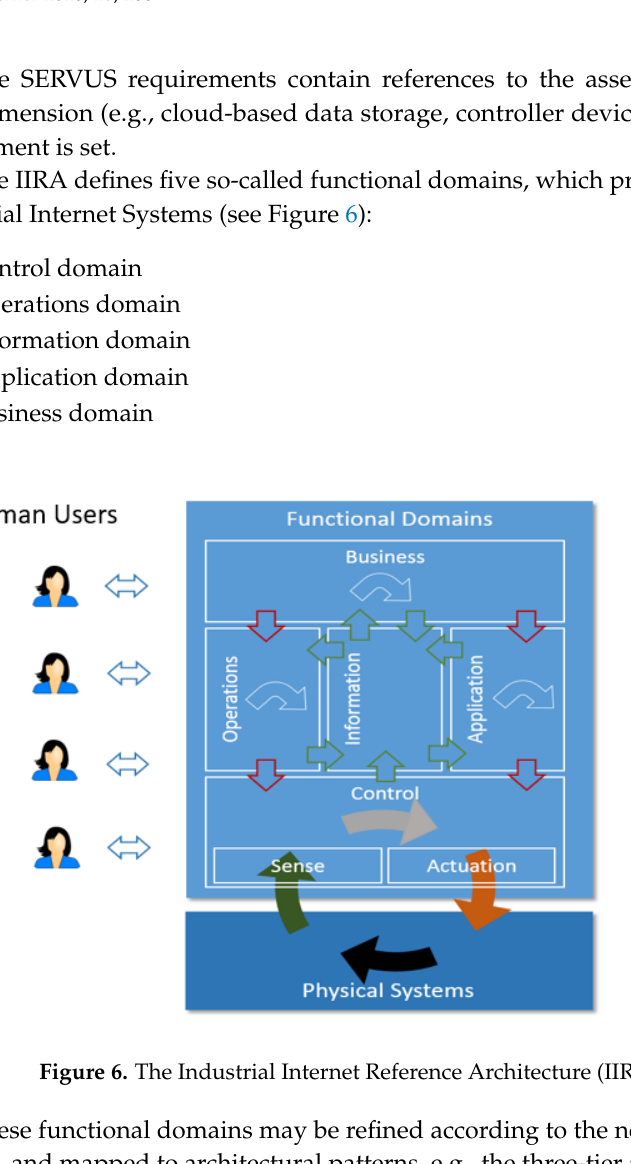
Figure 7. IIRA three-tier architectural pattern [2].